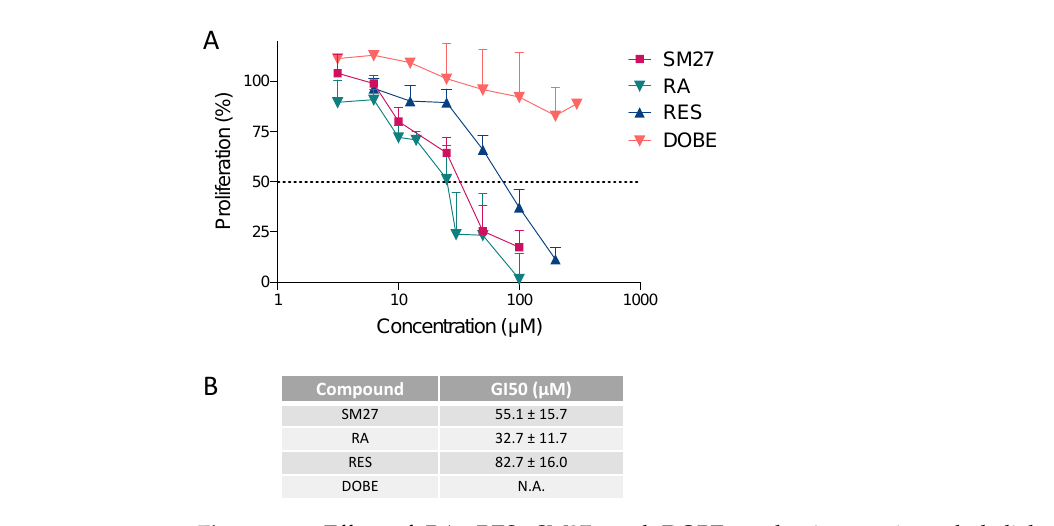
Figure 3. Effect of RA, RES, SM27, and DOBE on bovine aortic endothelial cells (BAEC). ( A ) Concentration-dependent inhibition of FGF2-induced BAEC proliferation by the compounds tested at the indicated concentration. Data are expressed as the percentage of control proliferation (mean and SEM). ( B ) GI50 values (in µM) for inhibition of FGF2-induced BAEC proliferation. N.A., not applicable; GI50 was not reached for DOBE.